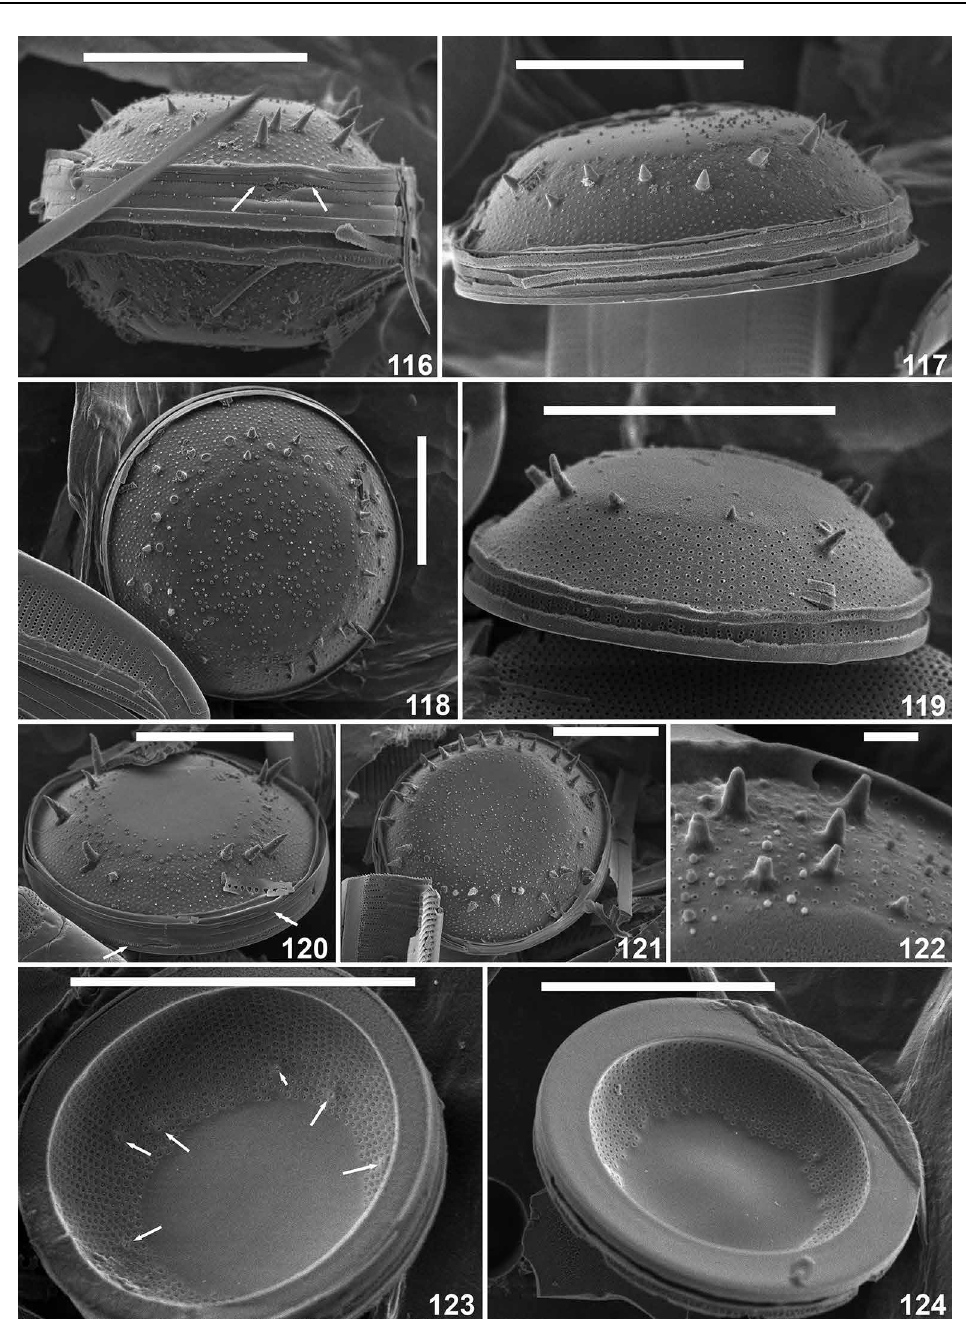
Figs 116–124. Arcanodiscus crawfordianus Goeyers & Van de Vijver sp. nov. SEM. Campbell Island holotype population, sample BAS303 (BR-4579). 116 . Frustule in girdle view. The arrows indicate the fimbriate pars interior of the copulae. 117 . External view of a valve in girdle view showing the domed valve face, the marginal spines and some of the narrow, unperforated copulae. 118 . External valve face view of an entire valve. Note the spines, the granules in the central area and the striae on the sloping margin. 119 . External view of a valve in girdle view showing the domed valve face, the marginal spines, the distinct marginal ridge and the mantle edge bordered by the relatively large groove. 120–121 . Several valve face views to show the irregular rings of spines. 122 . External detail of the spines and the granules. 123–124 . Internal views of an entire valve showing the rimoportulae (arrows). Scale bars: 116, 118–121, 123–124 = 10 μm; 117 = 5 μm; 122 = 1